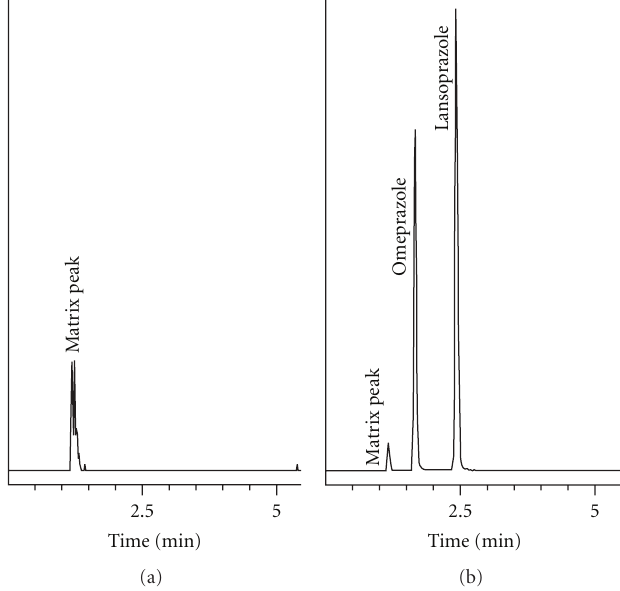
Figure 1: Sample chromatograms showing (a) solvent blank and (b) suspension sample (0hr).